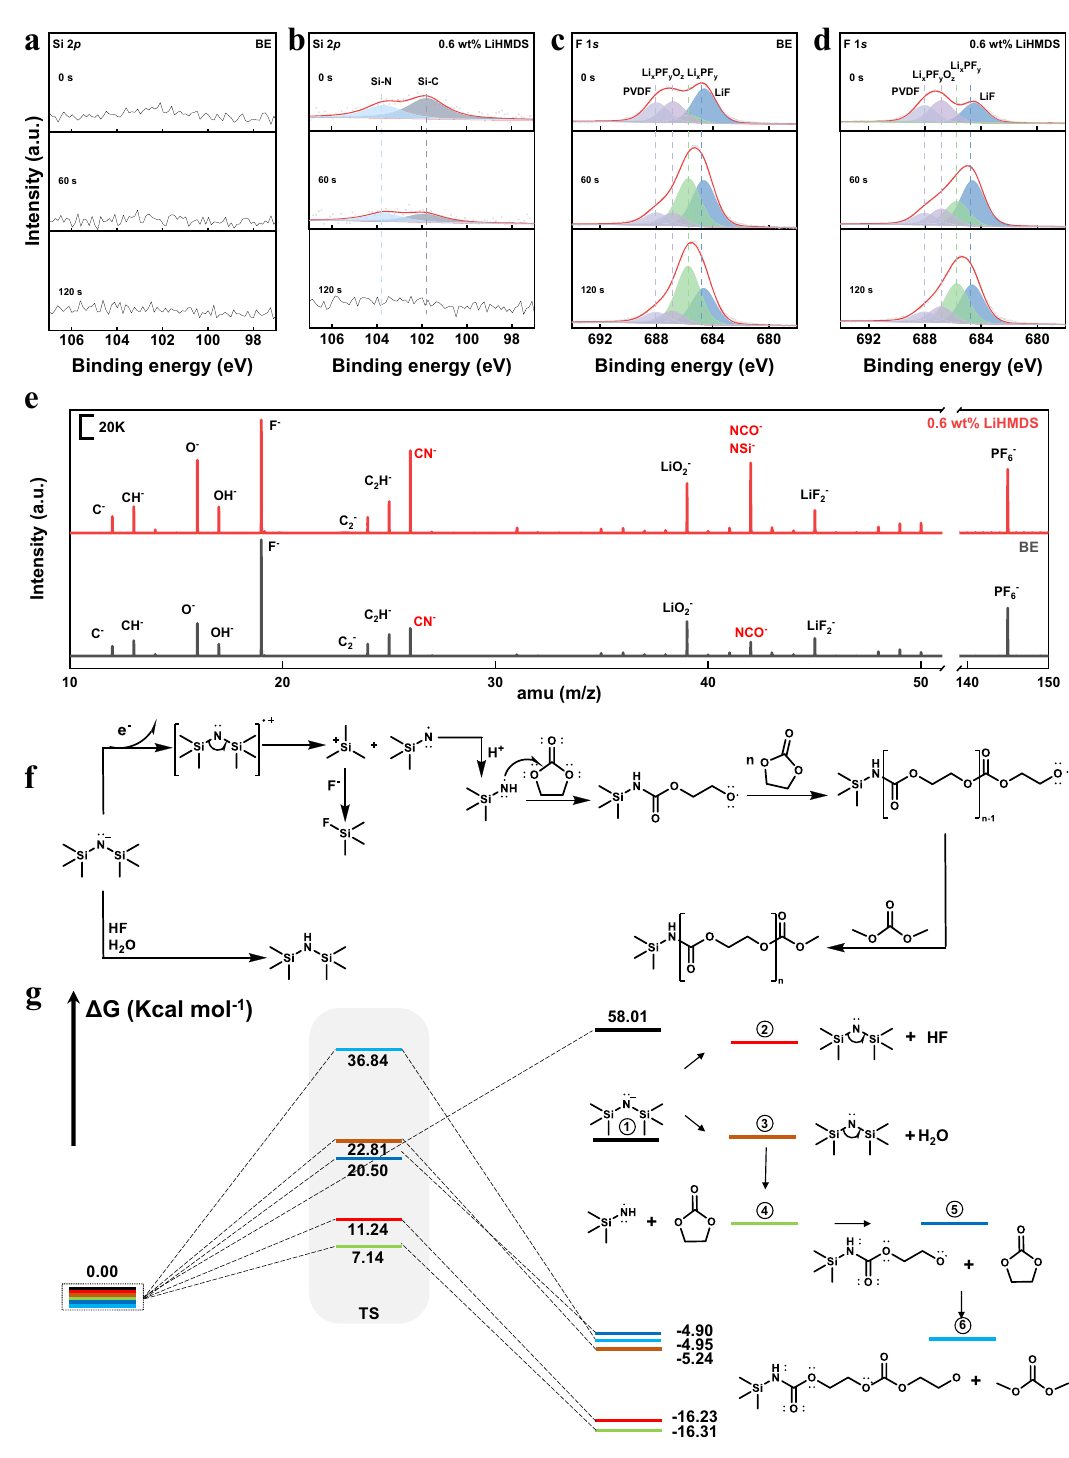
Fig. 2 | Surface component analysis of NCM811 cathode. Ex situ XPS measure- ments and analysis of NCM811 cathode retrieved from a , c Li||NCM811 cells and b , d Li||NCM811 cells with LiHMDS after 100 cycles at 60°C, the charging/dis- chargingcurrentwere180mAg − 1 /180mAg − 1 . a , b Si2 p , c , d F1 s . e ExsituTOF-SIMS